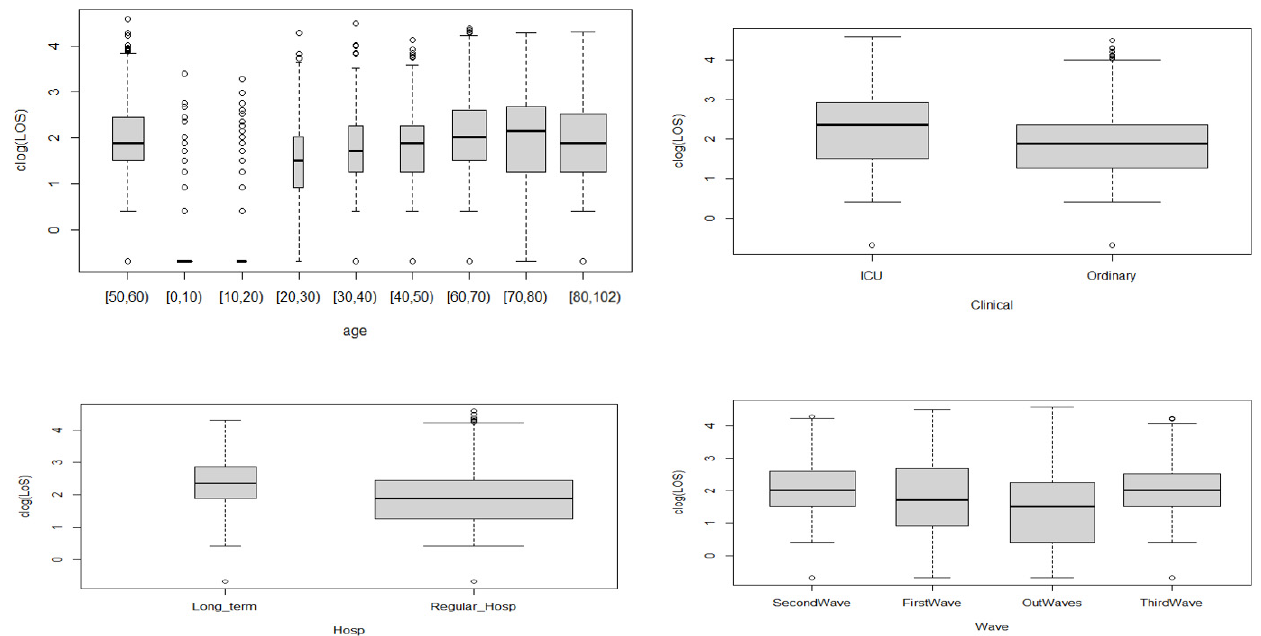
Figure 3. LoS plotted against the predictors used. All plots show the variation in LoS when the predictors were changed.